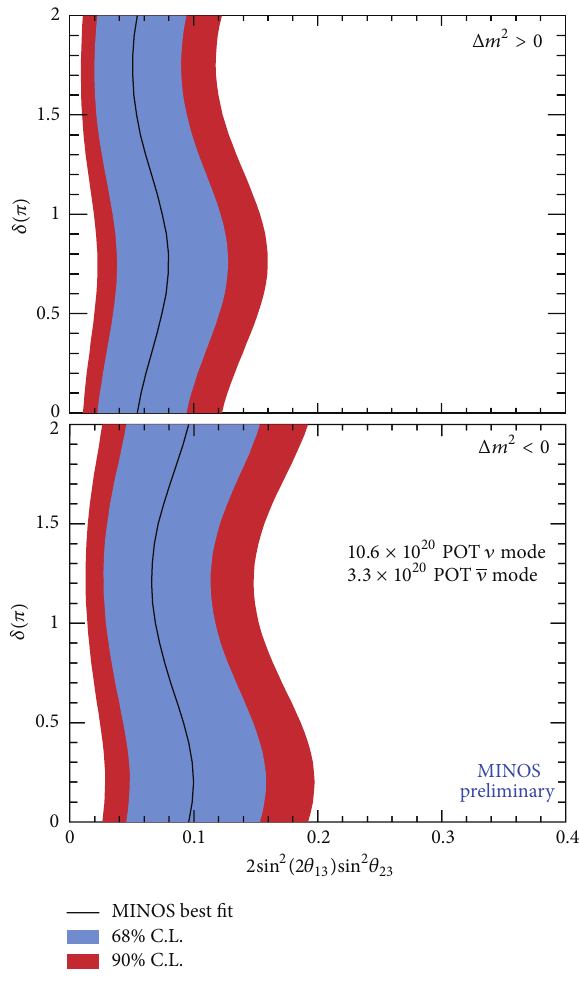
Figure 18: MINOS allowed regions for the CP violating phase and ) sin 2 𝜃 2 sin 2 (2𝜃 13 23 , obtained using the full data set of both neutrinos and antineutrinos. The top (bottom) plot assumes the normal (inverted) mass hierarchy. All values of the CP violating phase are consistent with the data and so the best fit parameters are shown by the black line. The blue (red) band shows the regions allowed at 68% (90%) confidence level. The 𝜃 13 = 0 hypothesis is disfavored at the 96% confidence level. These results were preliminary at the time of writing